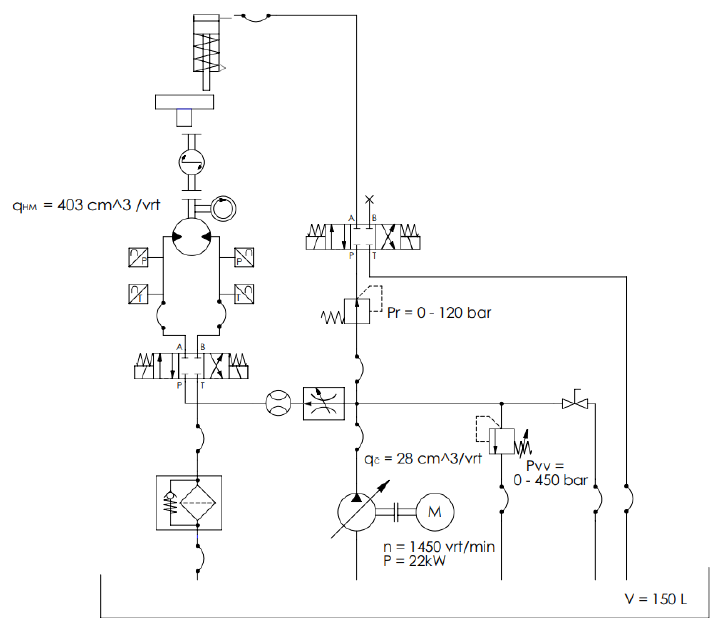
Figure 3. Hydraulic circuit of the test rig for evaluating the performance of the oil-based orbital hydraulic